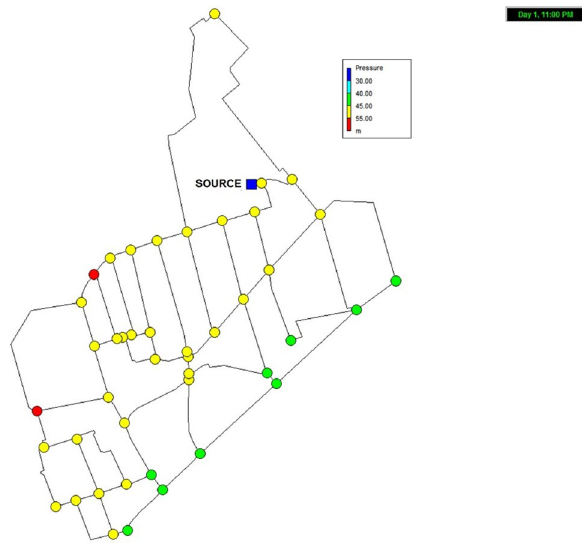
Fig. 7 Pressure distribution in nodes in the water supply network at the time of the lowest consumption